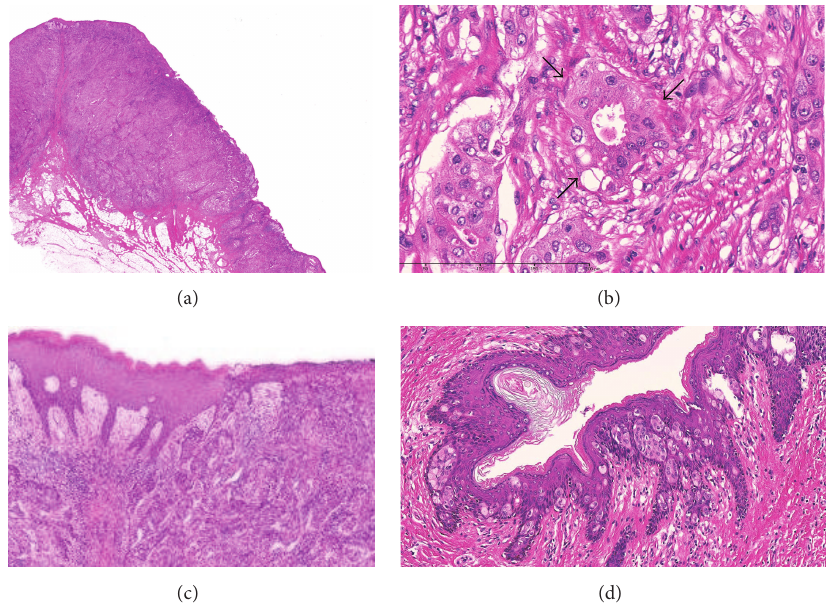
Figure 2: Morphologic findings (hematoxylin and eosin stain). (a) Tumor cells predominantly in the dermis with slight invasion into the subcutaneous tissue (magnification × 5). (b) The tumor cells showed granular eosinophilic cytoplasm and oval-round nuclei with prominent nucleoli and were arranged in solid, trabecular, and glandular patterns (magnification × 100). Partially decapitation-type secretion was seen (arrows). (c) The overlying epidermis was partially destroyed (magnification × 10). (d) Pagetoid spread of neoplastic cells in the peripheral epidermis of the tumor (magnification × 20).